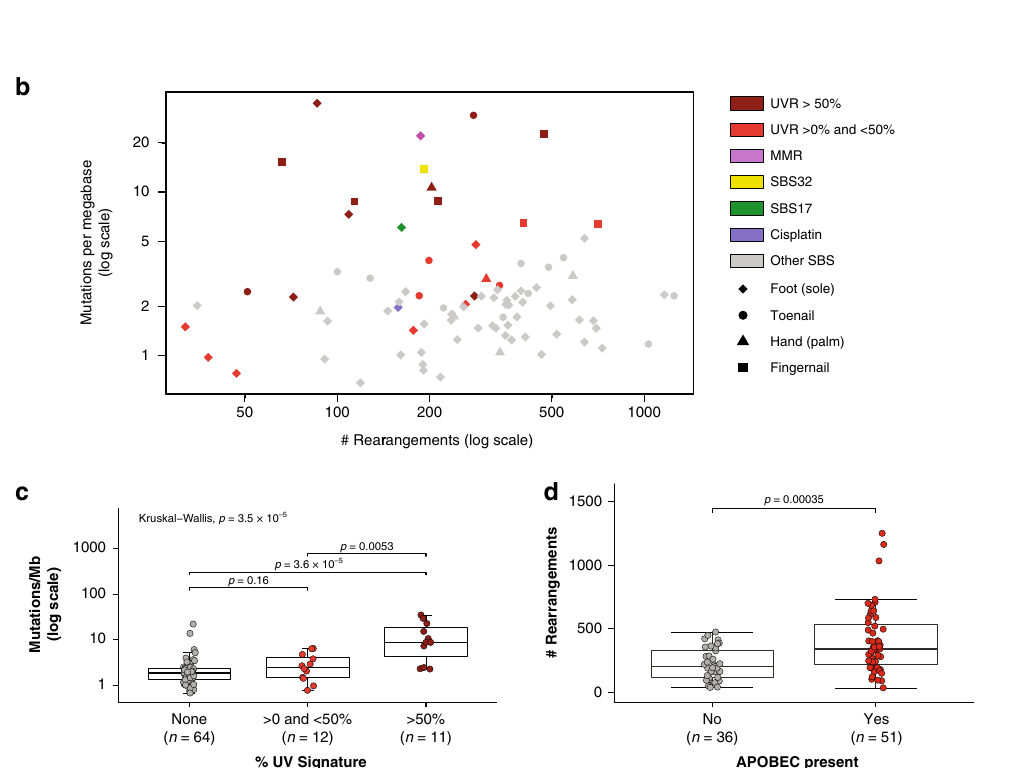
Fig. 2 Mutational signatures of point mutations, dinucleotide mutations and indels. a From top to bottom: mutations per megabase, proportion of SBS mutational signatures; number of DNVs; proportion of DNV signatures (DBS); number of indels; proportion of indel signatures (ID), specimen type (primary or recurrence/metastasis); site of primary tumor. b Scatterplot of mutations per megabase versus structural rearrangement count with points colored by SBS signatures and shape indicating different primary sites. c Box plot of mutation burden (SNV,DNV,TNV, small indel) across samples with different proportions of UVR signature. Kruskal – Wallis test was used to determine overall signi fi cance between the groups and pairwise Mann – Whitney U - tests to compare each pair. The pairwise test p -values displayed are adjusted p -values after correction for multiple testing by FDR. d Box plot of number of rearrangements in samples that have evidence of an APOBEC signature or have no evidence of the signature (Mann – Whitney U -test). In each box plot, the box boundaries show the fi rst to third quartiles, the median is the center line and the whiskers represent 1.5 times the inter-quartile